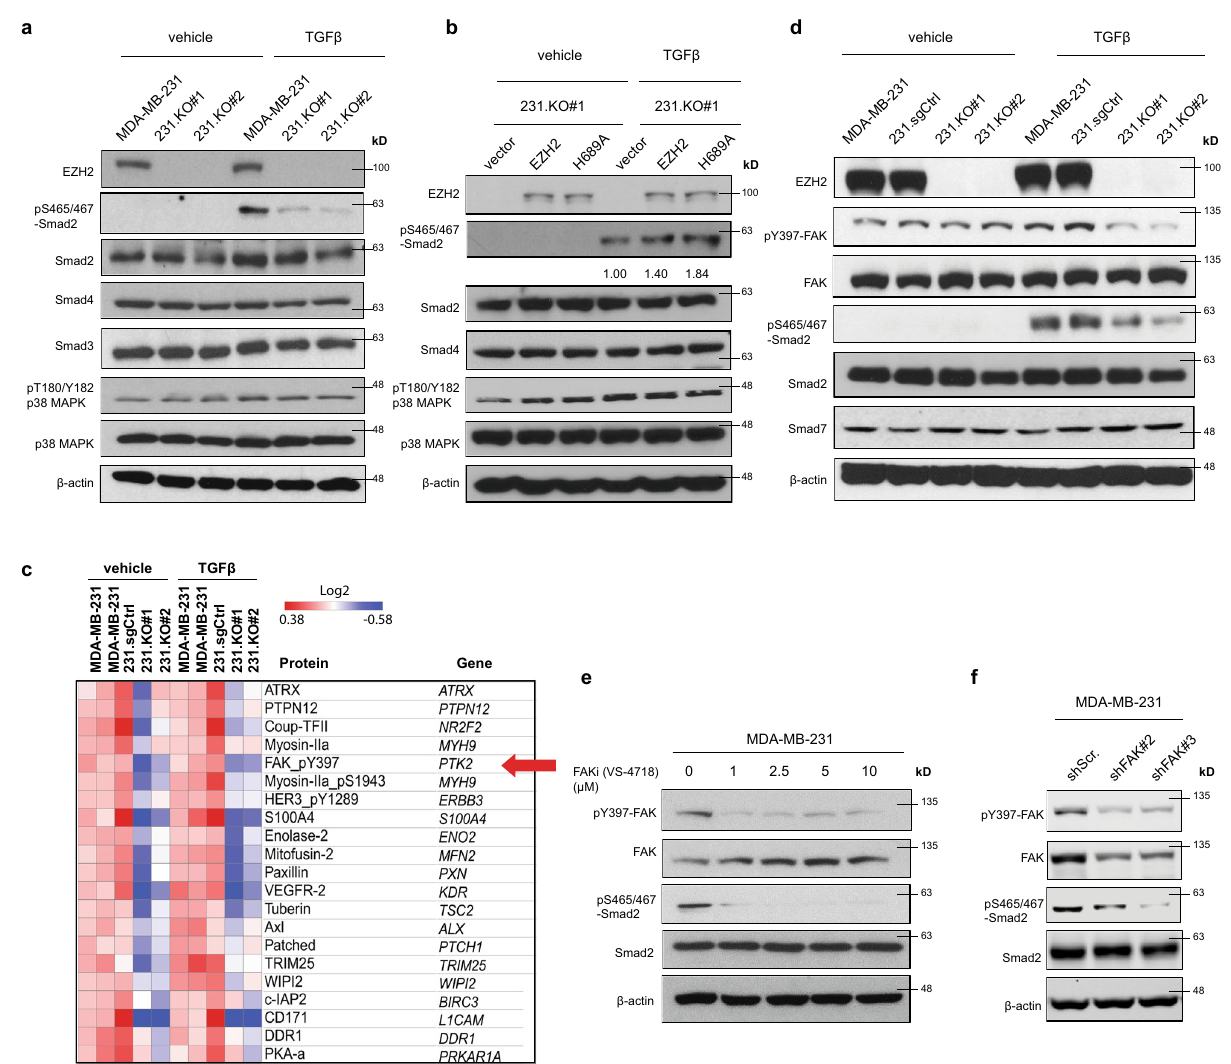
Fig. 3 EZH2 increases pS465/467-Smad2 and pY397-FAK levels in response to TGF β stimulation. a Western blotting of the expression of the indicated proteins in MDA-MB-231, 231.KO#1, and 231.KO#2 cells treated with a vehicle or TGF β (5 ng/mL) for 2 h. b Western blotting of the expression of the indicated proteins in 231.KO#1.vector, 231.KO#1.EZH2, and 231.KO#1.H689A cells treated with a vehicle or TGF β (5 ng/mL) for 2 h. c RPPA analysis of MDA-MB-231, 231.sgCtrl, 231.KO#1, and 231.KO#2 cells treated with a vehicle or TGF β (5 ng/mL) for 2 h. The heatmap shows the top downregulated proteins in 231.KO#1 and 231.KO#2 cells compared with MDA-MB-231 and 231.sgCtrl cells. d Western blotting of the expression of the indicated proteins in MDA-MB-231, 231.sgCtrl, 231.KO#1, and 231.KO#2 cells treated with a vehicle or TGF β (5 ng/mL, 2 h). e Western blotting of the expression of the indicated proteins in MDA-MB-231 cells treated with the FAKi VS-4718 at different concentrations (0 – 10 μ M) and with TGF β (5 ng/mL) for 2 h. f Western blotting of the expression of the indicated proteins in 231.shScr, 231.shFAK#2, and 231.shFAK#3 cells treated with TGF β (5 ng/mL) for 2 or Smad4 protein expressions (Fig. 3a and Supplementary Fig. 3a). Knockout of EZH2 didn ’ t change the level of pT180/ Y182-p38 MAPK, suggesting that EZH2 does not regulate TGF β - p38 MAPK signaling (Fig. 3a). Knockdown of EZH2 by shRNAs (shEZH2#3 and shEZH#4) yielded similar results in MDA-MB- 231 sublines (Supplementary Fig. 3b). To examine whether EZH2-methyltransferase function is involved in regulation of in 231.KO#1 sublines that have re-expression of the control vector, wild-type EZH2, or H689A EZH2, in response to TGF β (Fig. 3b). Like wild-type EZH2 re-expressing cells, H689A EZH2 re-expression also increased the level of pS465/467-Smad2 com- pared with the control vector (Fig. 3b). Furthermore, GSK126 treatment had no signi fi cant impact on increased pS465/467- Smad2 by TGF β treatment (Supplementary Fig. 3c).